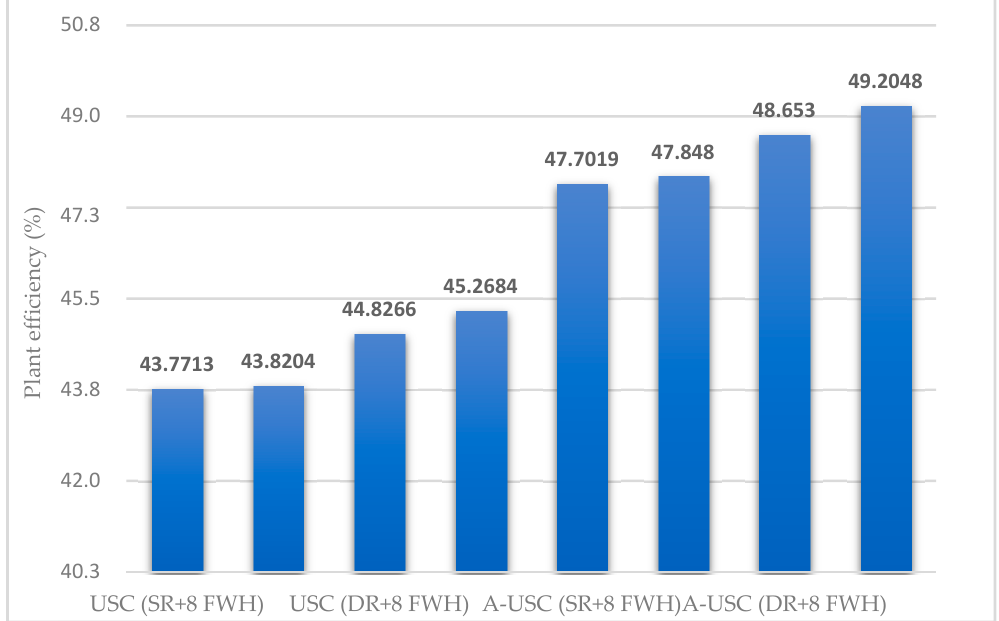
Figure 7. Comparison of plant efficiency with USC & A-USC.